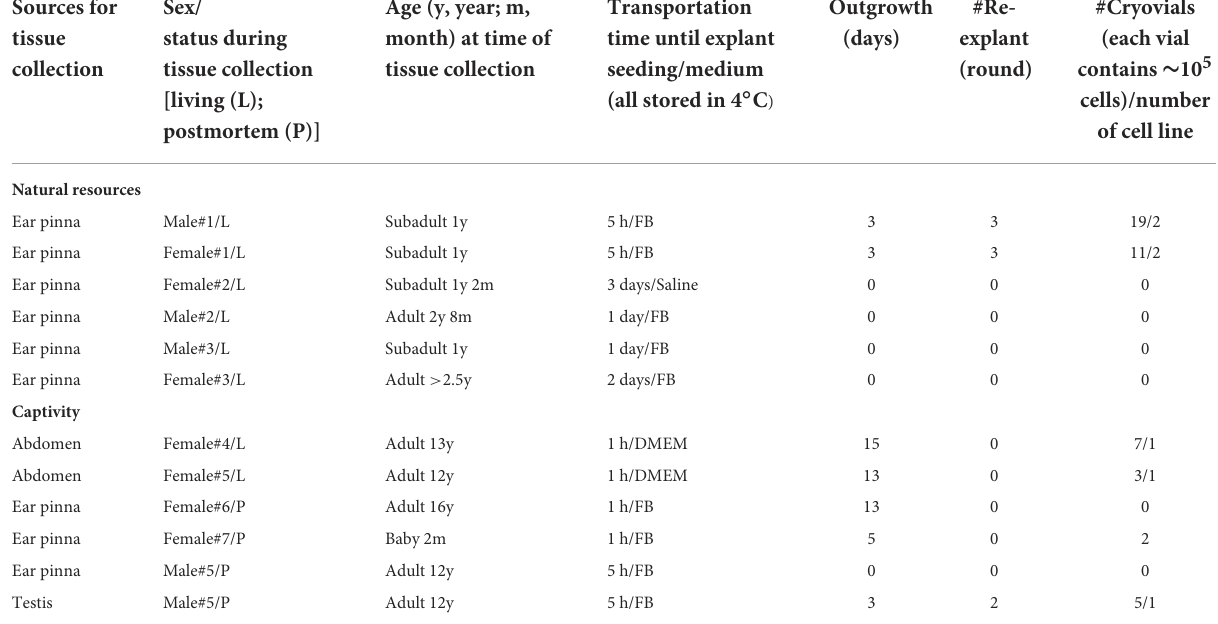
TABLE 1 Primary culture of fishing cat tissues from various sources. Sources